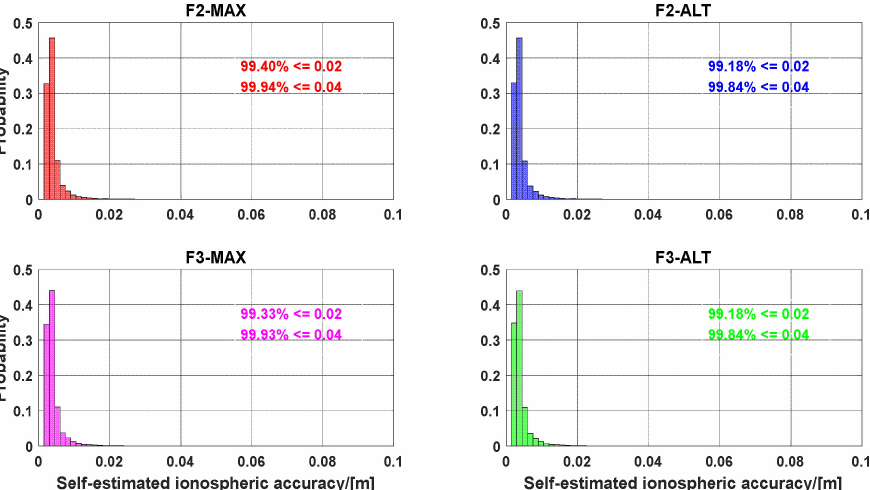
Figure 12. Accuracy distribution of the estimated slant ionospheric delays derived from the user